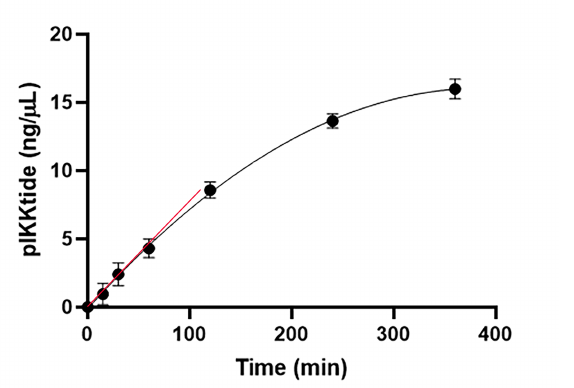
Figure 2. Time-course kinetics of the phosphorylation of IKKtide by IKK α . The kinase assay was performed as described in the text, the results were analyzed by measuring the area of the peak corresponding to the pIKKtide (at m/z 951.4 MH3 + ) and the area was converted in ng/ µ L. The results are reported as mean ± S.E.M. of data obtained by three independent experiments (N =